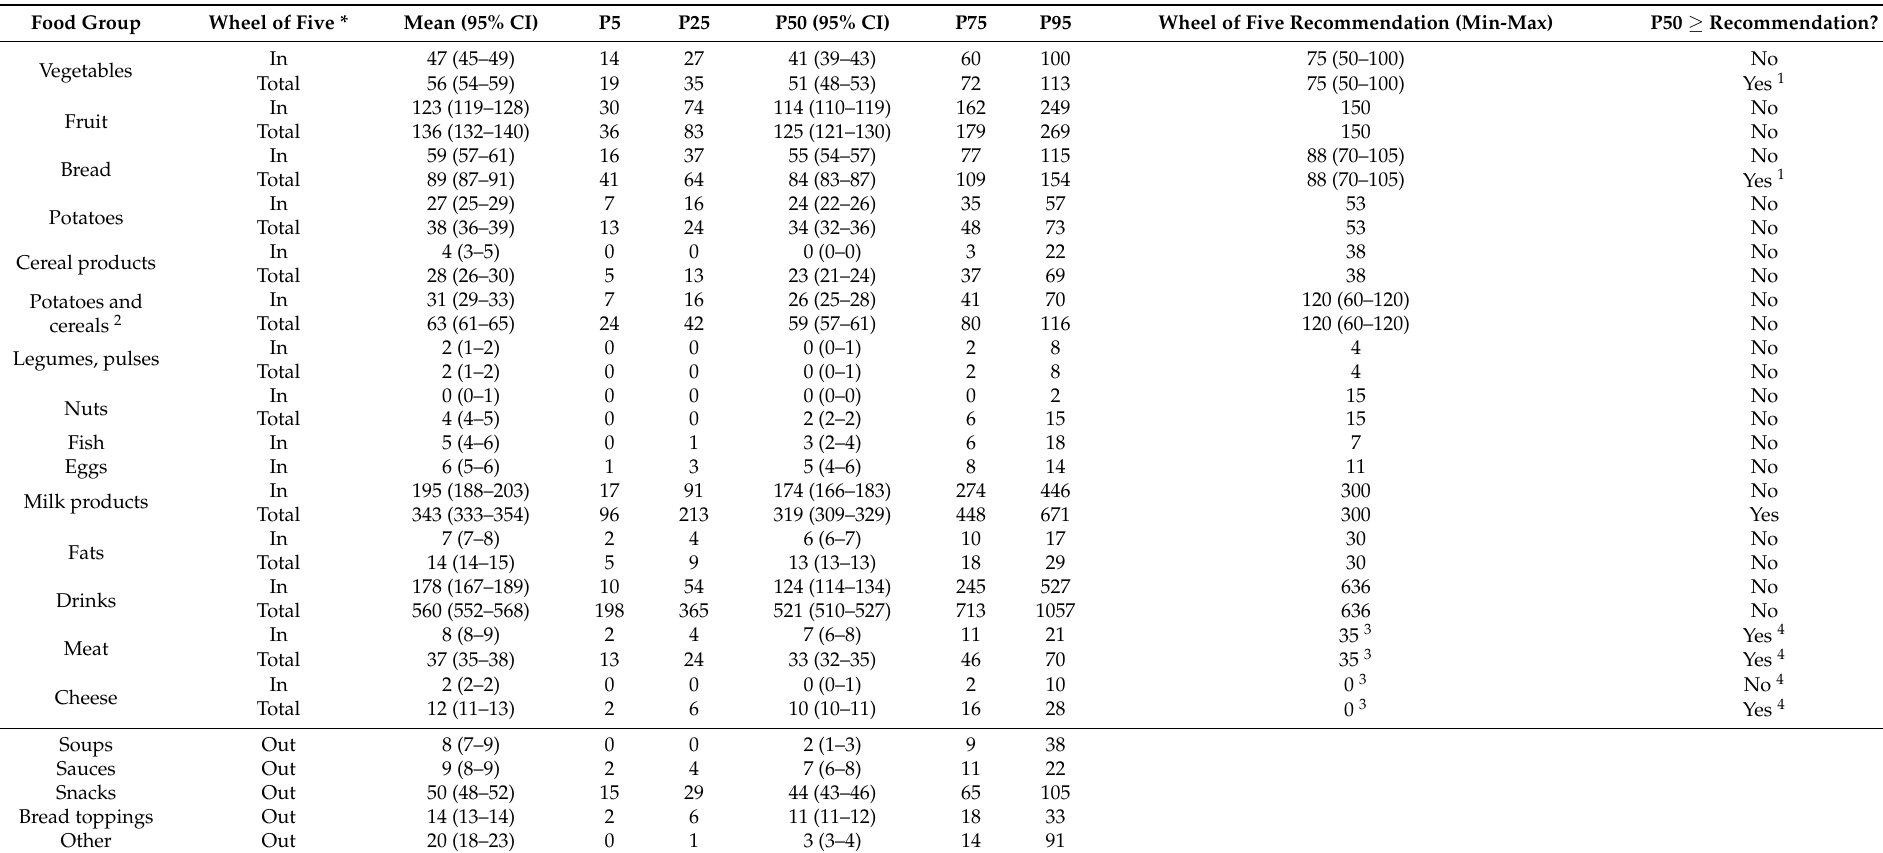
Table 3. The distribution of habitual consumption of several food groups (in g/day) by Dutch children aged one to three years, compared to the guidelines of the wheel of five (DNFCS 2012–2016, n = 672, weighted for demographic characteristics, season and day of the